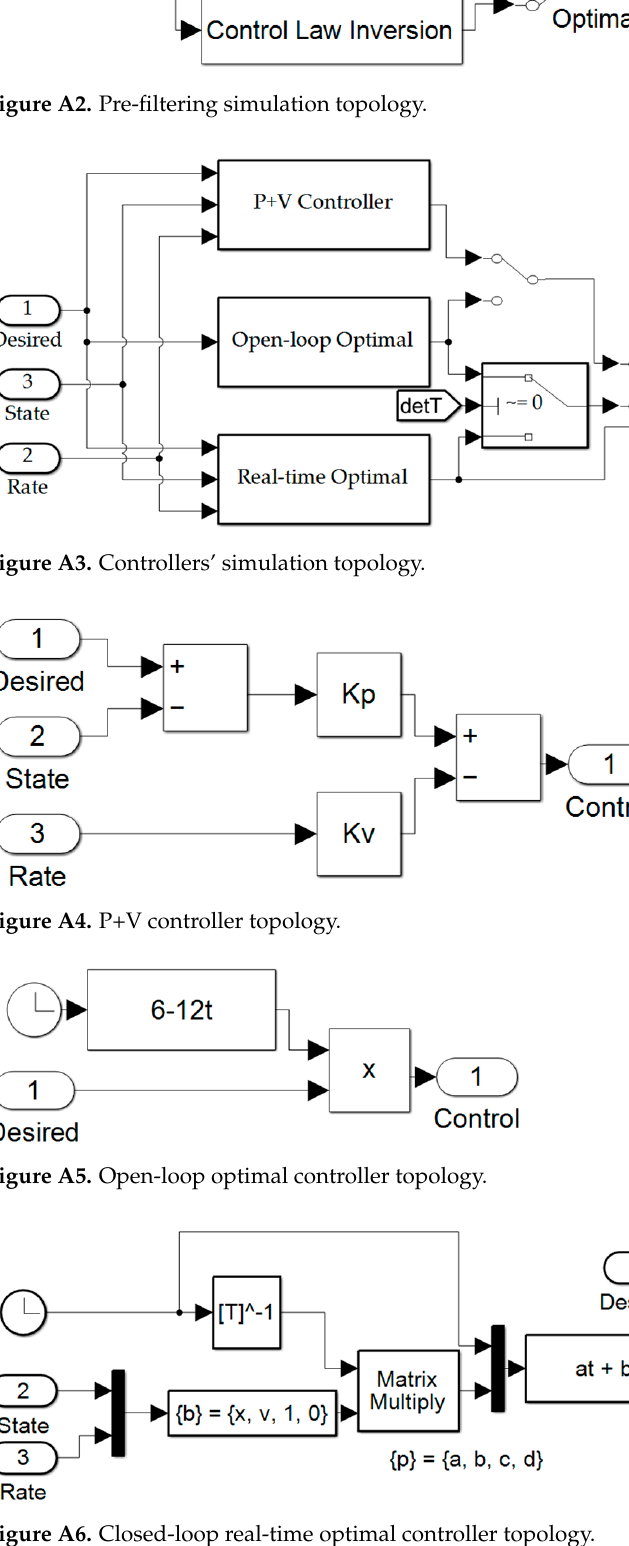
Figure A7. Spacecraft simulation topology. Figure A8. Noisy sensor-fusion simulation topology. Appendix B. MATLAB Wrapper Code % If you are running this script, go into the Simulink model callbacks. % Under StopFcn, set ‘graphit’ to 0, or MATLAB will plot the individual % simulation results... n times. This cuts down total run time by about % half. close all n = 1000; state_f = zeros(1,n); rate_f = zeros(1,n); J_stor = zeros(1,n); for i = 1:n rng(‘shu ffl e’); simout = sim(‘FinalProject’); state_f(i) = simout.state(end); rate_f(i) = simout.rate(end); J_stor(i) = simout.J(end); i end sca tt er(state_f, rate_f, ‘MarkerEdgeColor’, ‘b’) box on grid on hold on